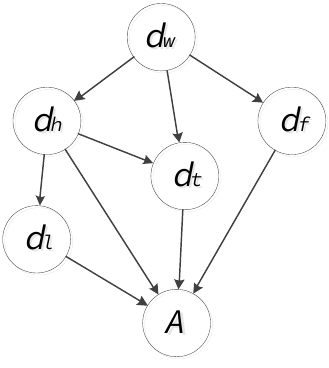
Figure 2. BN structure of marine hazard assessment.